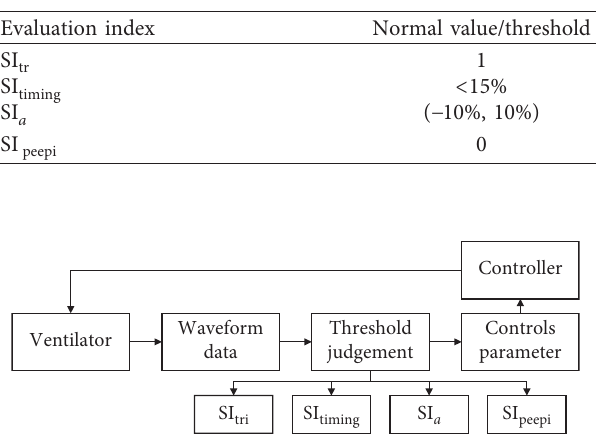
as the response